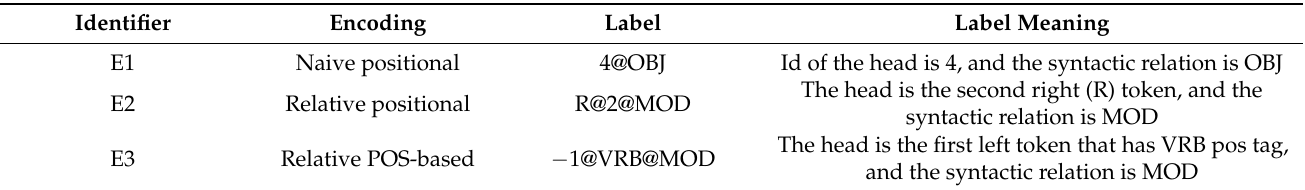
Figure 1. Types of encoding on an example for Arabic parse tree from ArPoT [19,20]. 1 In this work, we applied Arabic to Buckwalter transliteration using CAMeL Tools at: https://github.com/CAMeL- Lab/camel_tools (accessed on 4 February 2023). Table 1. Head position encoding methods with an explanation of labels.